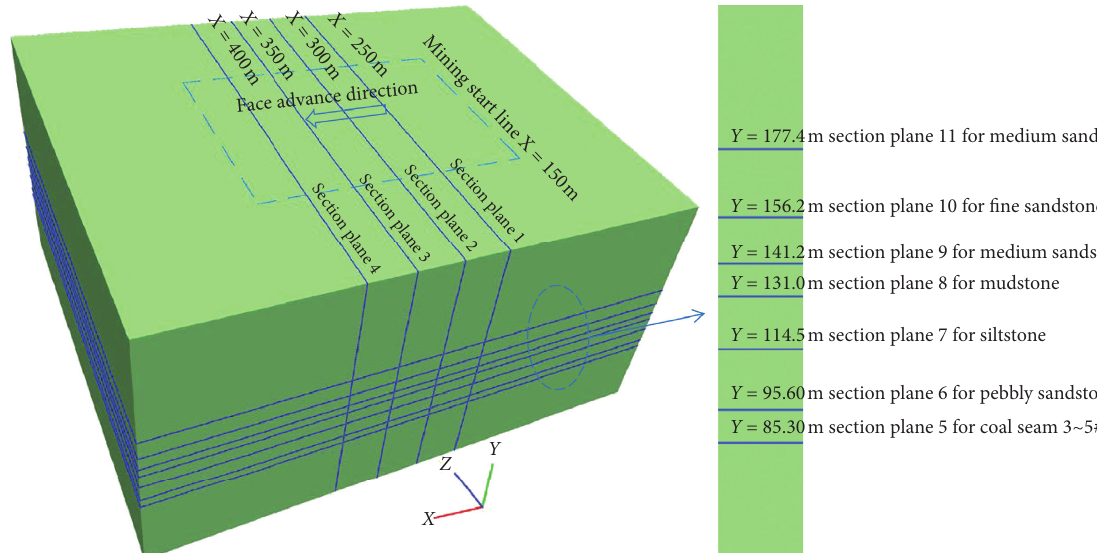
Figure 5: Section plane setup in the model.